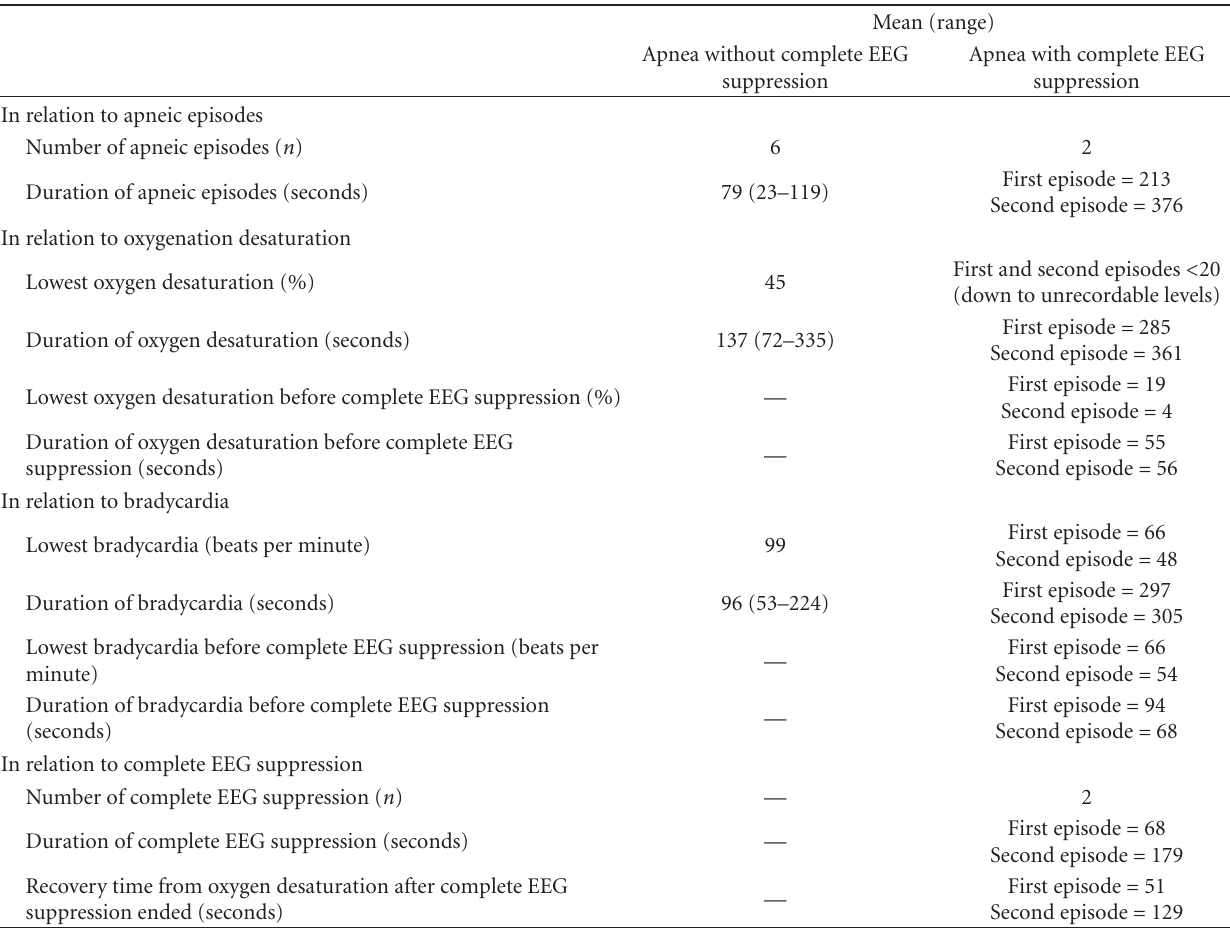
Table 1: Physiological characteristics of apneic events not associated with complete EEG suppressions and those with complete EEG suppressions recorded in the